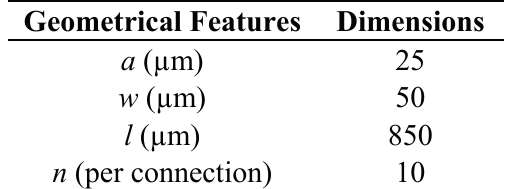
Table 1. Geometrical parameters of the IDEs in droplet